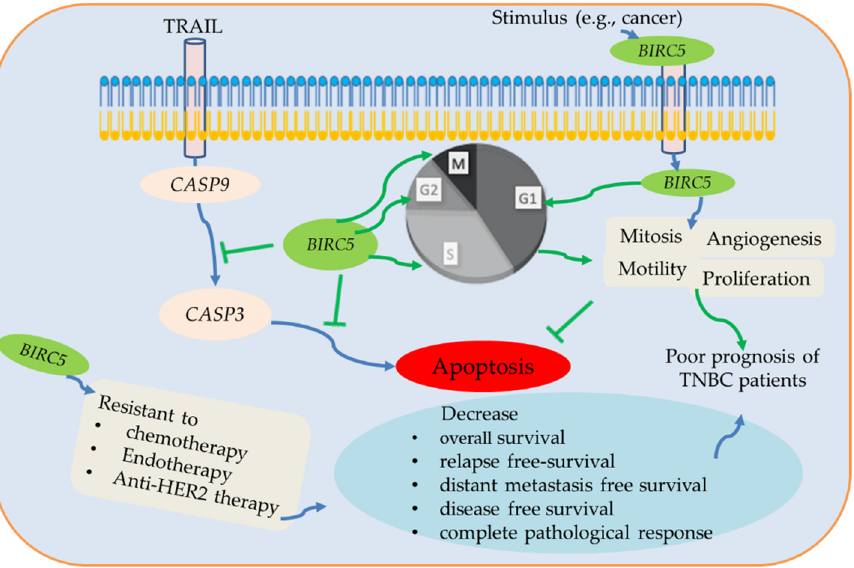
Figure 15. The potential BIRC5 pathways and their association with TNBC. BIRC5 inhibits apoptosis by preventing CASP9/3 activation and promoting cell division by regulating the various stages of the cell cycle. Additionally, BRIC5 is resistant to chemotherapy, endotherapy, and anti-HER2 ther- apy, which reduces complete pathological response and relapse-free survival of TNBC patients. Due to all of these conditions, BIRC5 expression has been associated with a poor prognosis for TNBC patients, suggesting that it may be a potential therapeutic target for the treatment and prevention of TNBC patients. TNBC